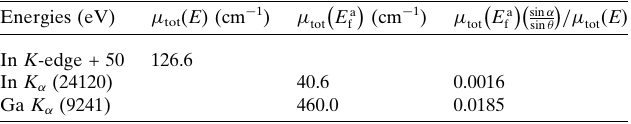
Table 1 Terms in the denominators of equations (3) and (4) for (cid:5) / (cid:6) = 0.1 (cid:3) /20 (cid:3) †. Energies